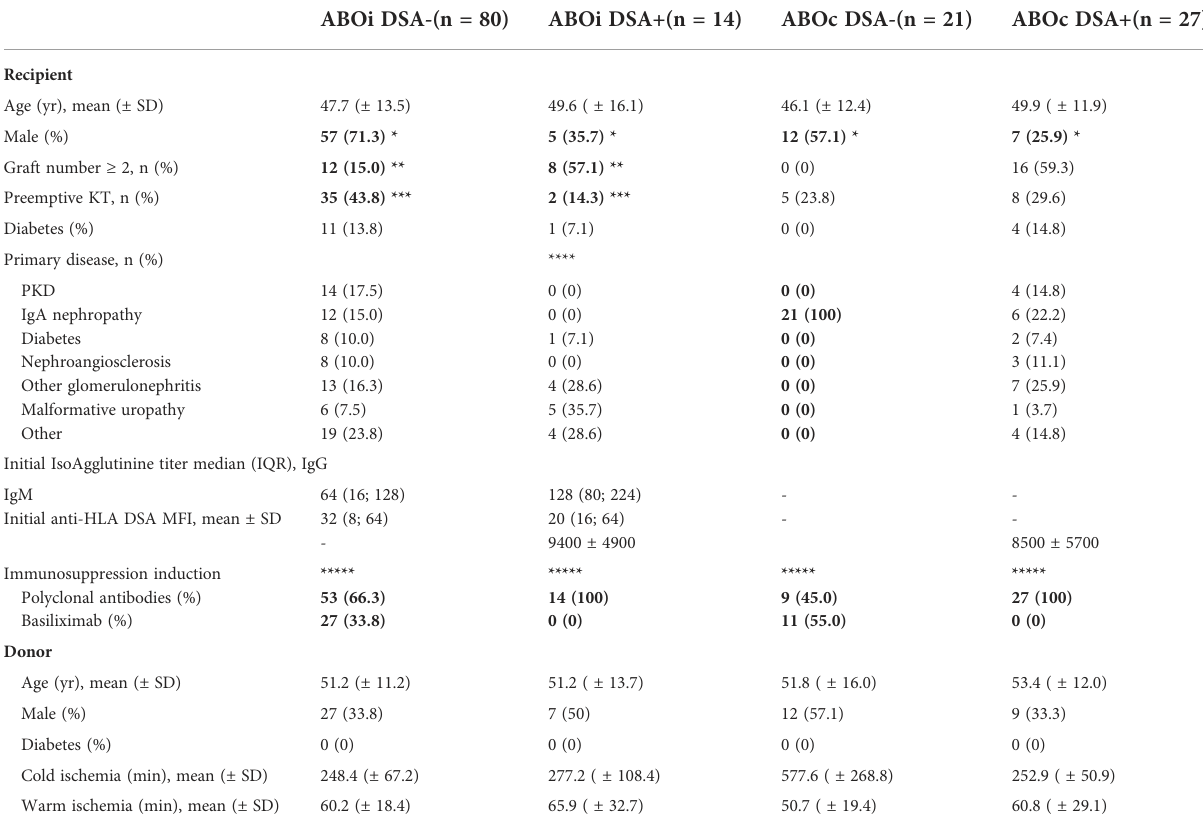
TABLE 1 Main patients ’